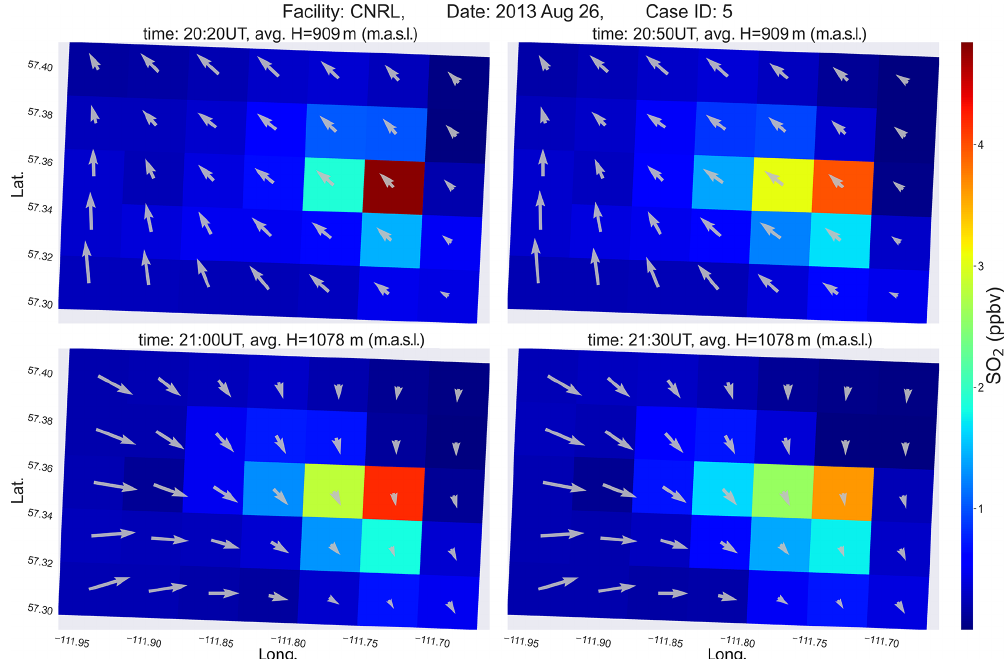
Figure 9. SO 2 mixing ratio horizontal cross sections at two (consecutive) plume center (max. conc.) heights (meters above sea level – ma.s.l.) and four time steps, during the period of case 5 over CNRL. The strength and direction of the airflow at each cross section is represented by grey arrows. Corresponding time and average height are noted for each panel. As the plume rises into layers with different wind direction over time, it re-circulates within the volume of the box which in turn results in a storage event.